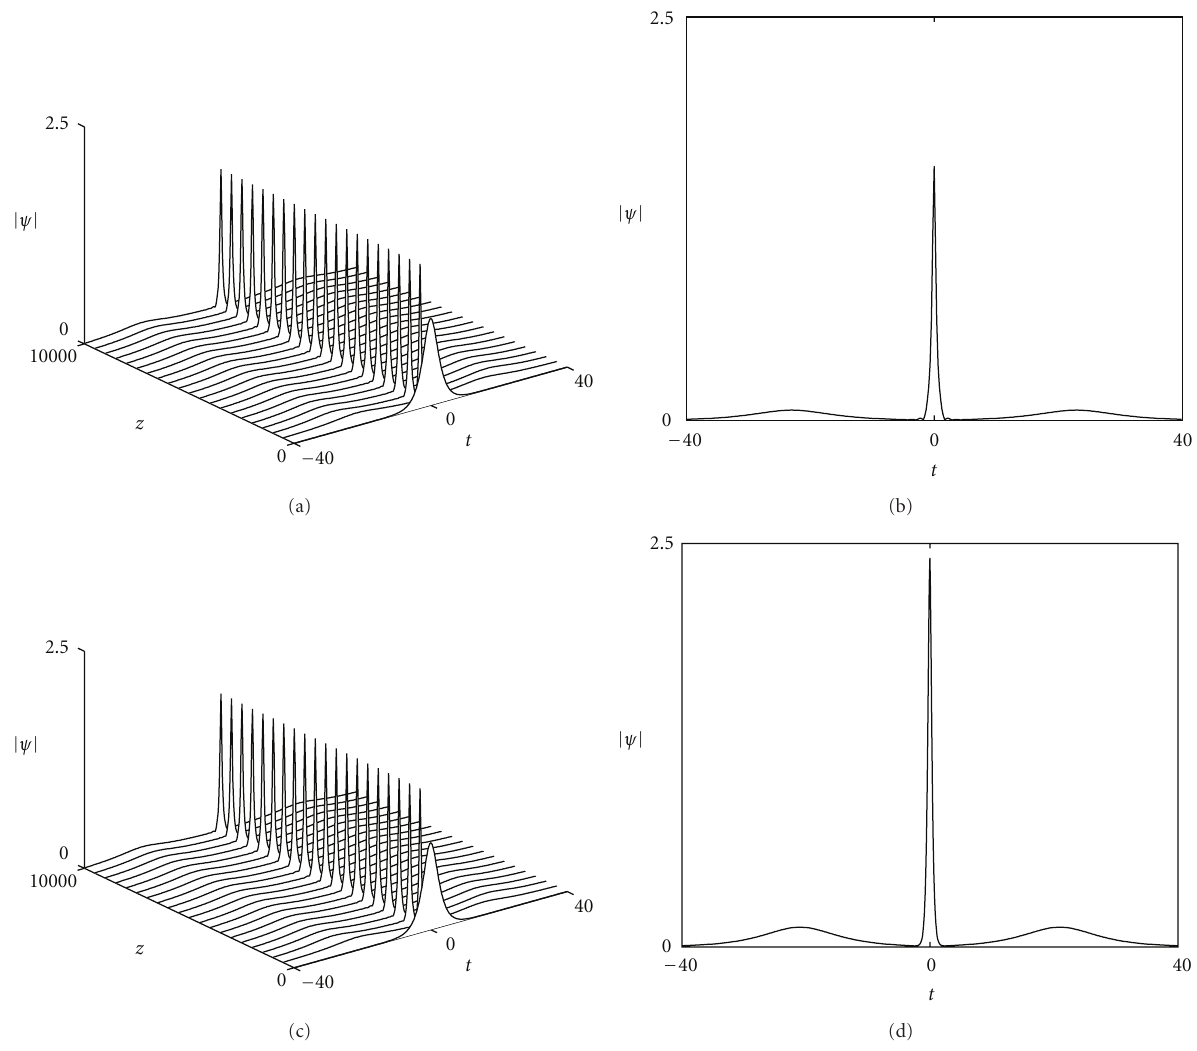
Figure 9: Transition dynamics observed in the anomalous dispersion regime. (a) and (b) Simulations of the full governing equations at g 0 = 1 . 9 ((a) and (c)) and the corresponding pulse profile ((b) and (d)). (c) and (d) Simulations of the SGLE at g 0 = 2 . 25 ((a) and (c)) and the corresponding pulse profile ((b) and (d)). The rest of the parameters in the simulations are D = 0 . 4, α 1 = 0, α 2 = 0 . 82 π , α 3 = 0 . 1 π , α p = 0 . 45 π , K = 0 . 1, Γ = 0 . 1, e 0 = 1, and τ = 0 . 1. The initial conditions in all the simulations are ψ (0, t ) = sech 0 . 5 t (from [29], 2011,